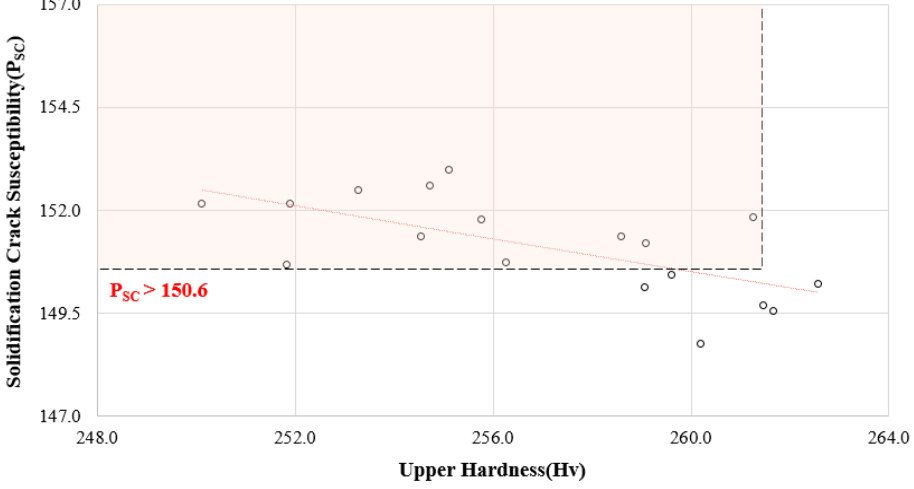
Figure 8. P SC distributions depending on upper hardness in flux-cored arc welding.